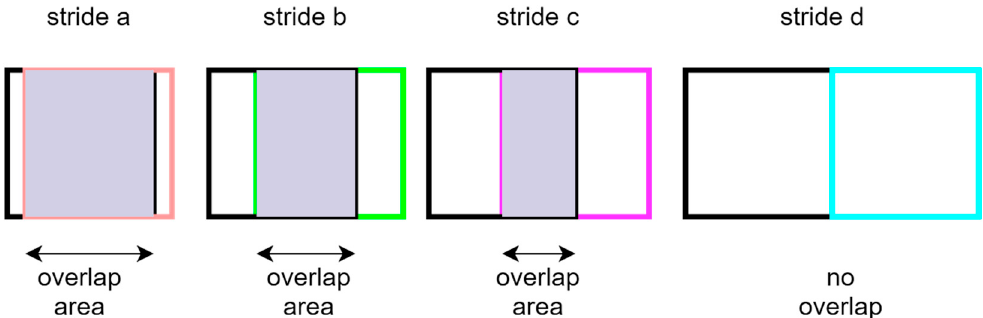
Figure 3. Four examples of different stride values of two consecutive frames in ascending order, where the stride value a < b < c < d.